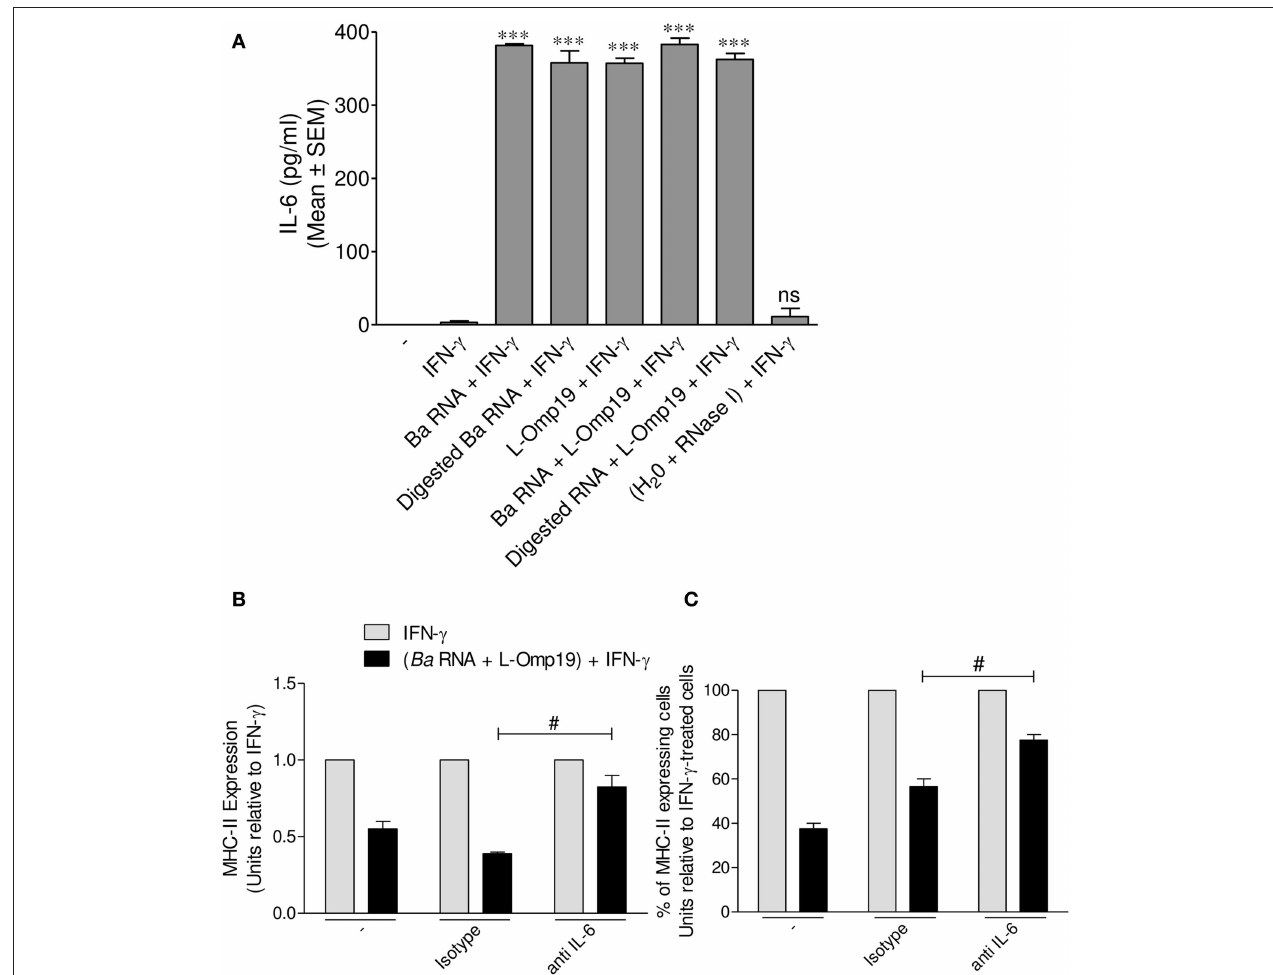
FIGURE 8 | IL-6 is a soluble mediator involved in B. abortus RNA and L-Omp19-mediated MHC-II down-modulation. (A) THP-1 cells were treated with B. abortus RNA (10 µ g/ml), digested B. abortus RNA, L-Omp19 (1 µ g/ml) or their combination in the presence of IFN- γ for 48h. Then, supernatants were harvested and IL-6 secretion was quantified by ELISA sandwich. (B,C) THP-1 cells were treated with B. abortus RNA (10 µ g/ml) and L-Omp19 (1 µ g/ml) in the presence of IFN- γ and in the presence of neutralizing anti-IL-6 or its isotype control for 48h. MHC-II expression was assessed by flow cytometry. (B) Bars represent the arithmetic means ± SEM of MHC-II positive cells corresponding to three independent experiments. (C) Quantification of cells expressing MHC-II (MHC-II positive cells). Data is expressed as the percentage of cells relative to IFN- γ ± SEM of three independent experiments. MFI, mean fluorescence intensity; ns, non-significant. *** P < 0.001 vs. IFN- γ -treated cells; # P < 0.05 vs. isotype